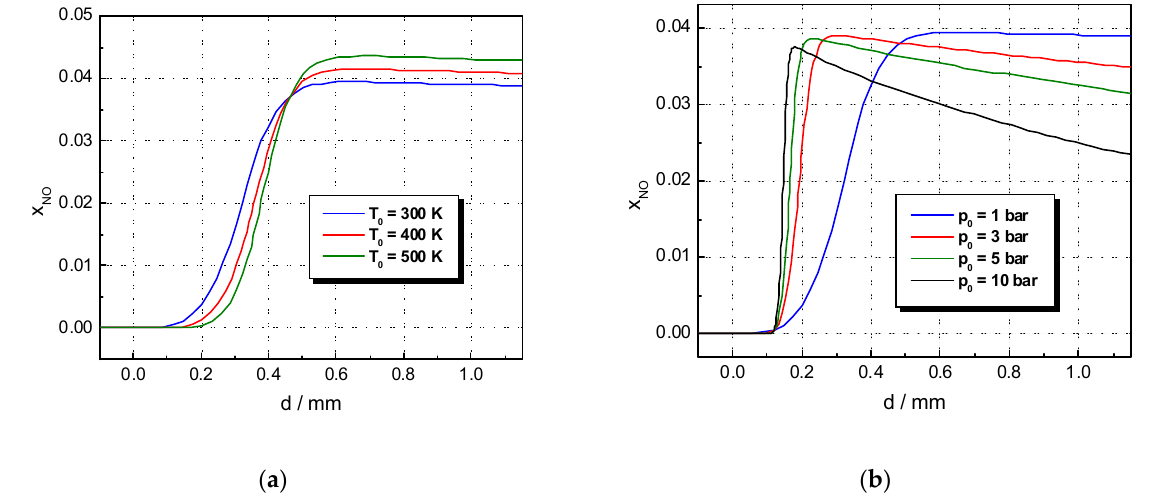
Figure 5. NO profiles of the flame front of a N 2 –diluted stoichiometric H 2 –N 2 O flame (N 2 = 40 vol%): ( a ) mixtures at 1 bar and various initial temperatures; ( b ) mixtures at 300 K and various initial pressures. It was also worth examining the end temperature and mass fraction of NO of the burned gas as functions of the initial conditions of the fresh, unburned gas. The addition of nitrogen into the H 2 –N 2 O mixture resulted in a decrease in the mass fraction of NO (Figure 6a,b) and the flame temperature in the burned gas (Figure 7a,b), as shown by data that were obtained at several different initial temperatures and pressures. The inerting effect was due both to dilution (the decrease in the amount of fuel determines the decrease mixture, since the inert component acted as a heat sink.